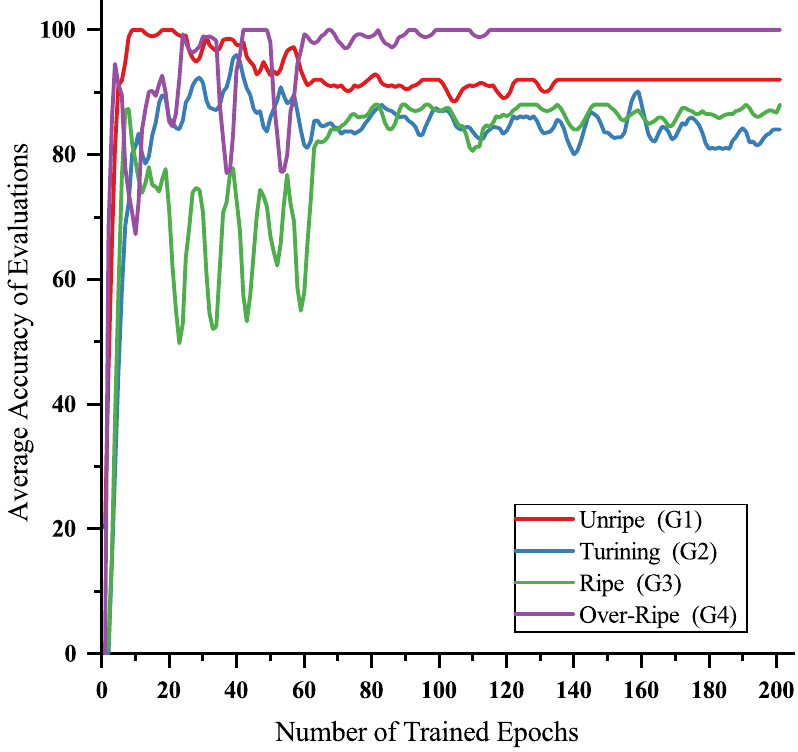
Figure 6. The relationship between the accuracy of each maturity grade and the different training